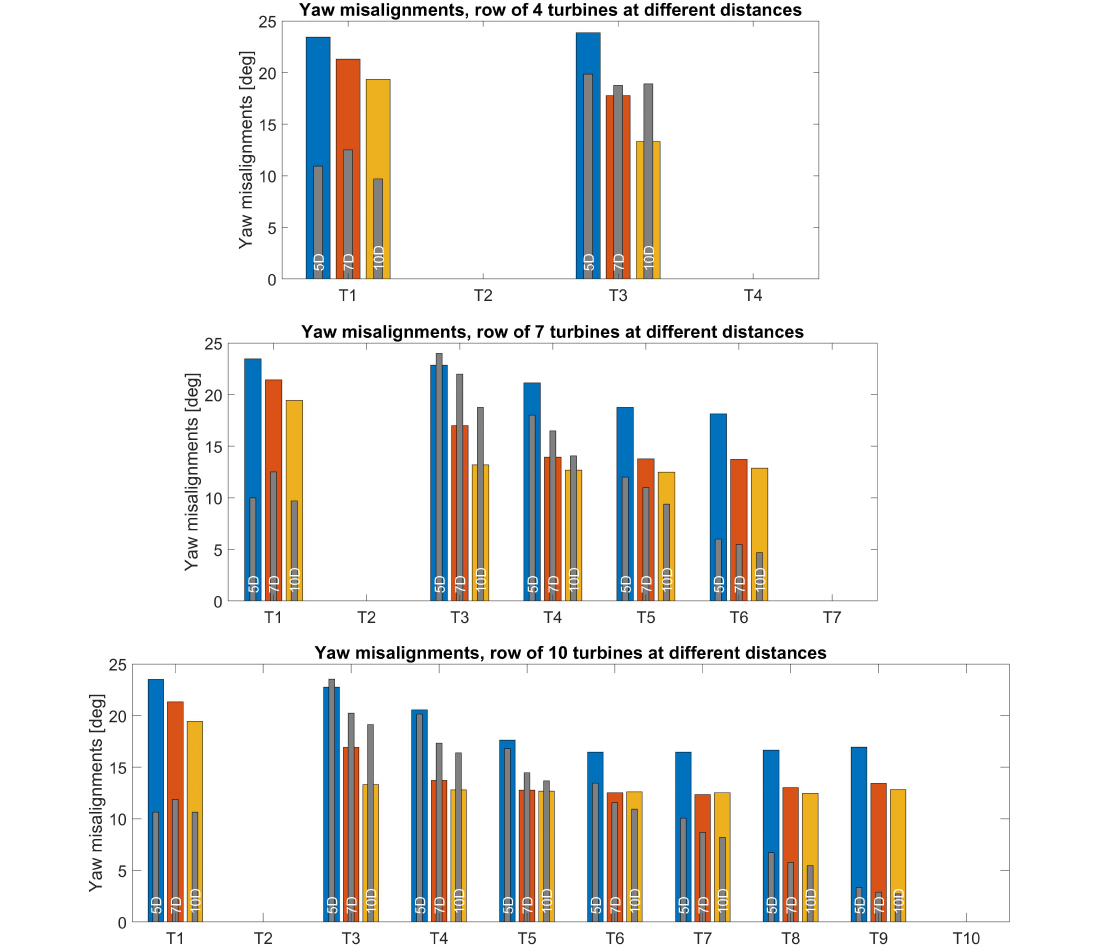
Figure 3. Nominal (thick bars) and re-optimized yaw misalignment angles (narrow bars) for the case when the second turbine T2 is not operational, ( middle ) row of 7 wind turbines, ( bottom ) row of 10 wind